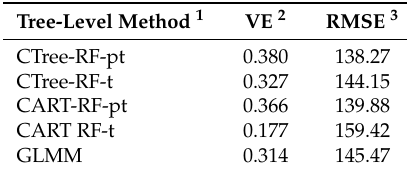
Table 3. Harvested volume predictions on plot level from random forest (RF) based on conditional inference trees (CTree-RF), RF based on classification and regression trees (CART-RF), and generalized linear mixed models (GLMMs) (1894 plots with 15,960 sample